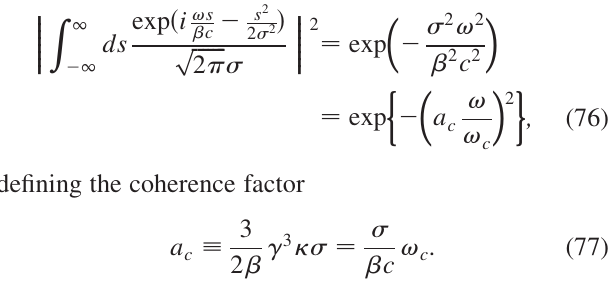
The total power spectrum per particle for an N -particle Gaussian distribution with various values of a c is shown in Fig. 16. One sees from the exponential that the lower frequencies, up to a cutoff frequency around ! ¼ (cid:4)c=(cid:10) , are enhanced by a factor of N by the coherent part of